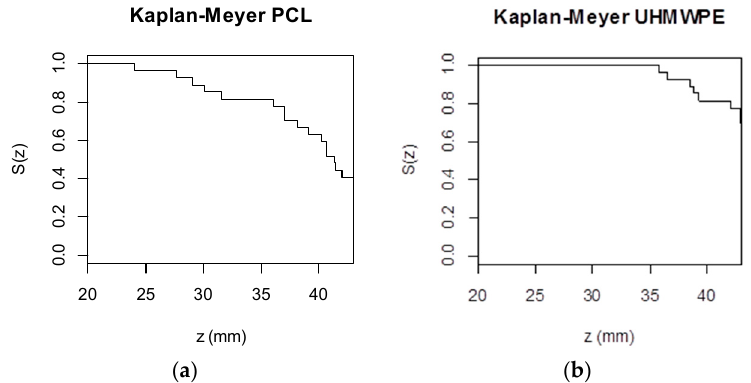
Figure 5. Kaplan-Meyer curves without separating by factor levels for ( a ) PCL and ( b ) UHMWPE.